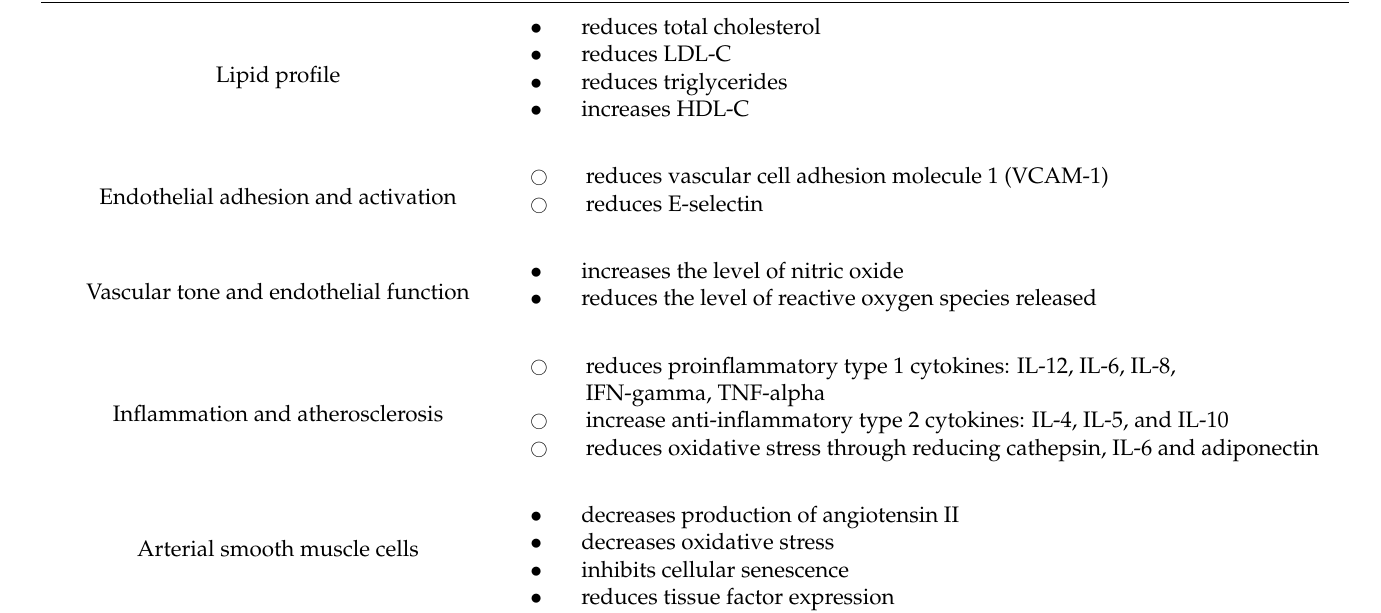
Table 2. Vitamin D effects on